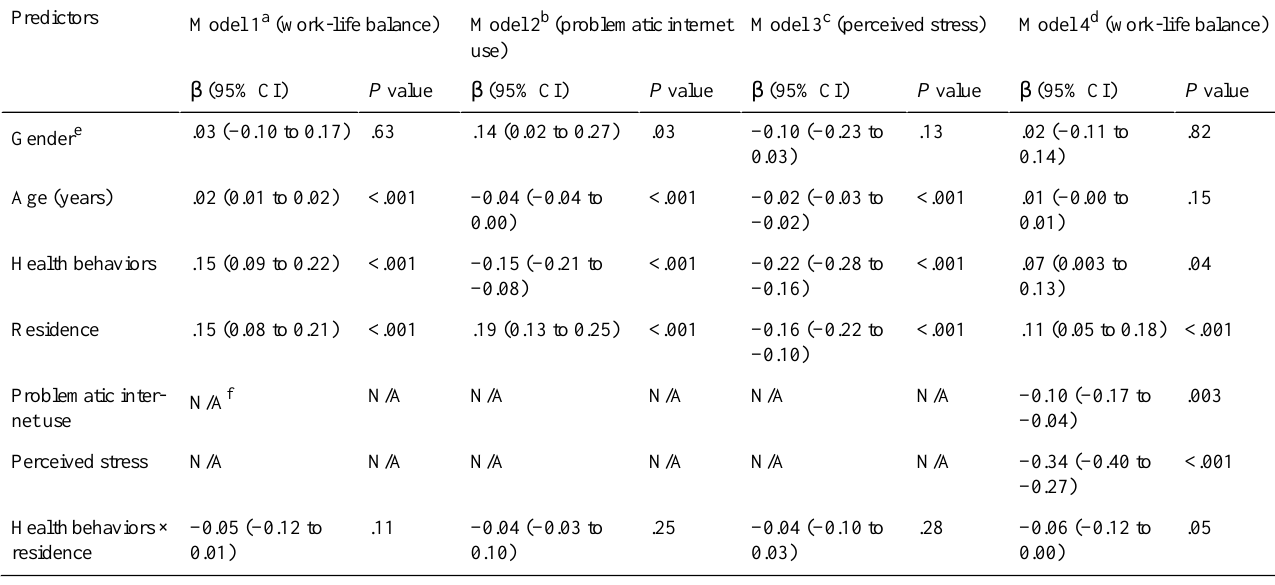
Table 4. Mediated moderation effects of health behaviors on work-life